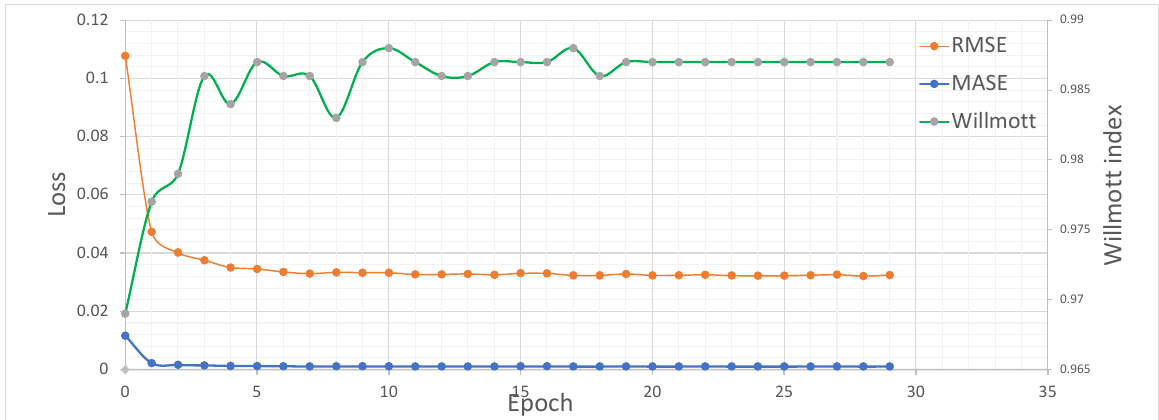
however Willmott’s index was around 0.987 with space of improving. The optimum values were in Epoch 10 with minimal MASE, RMSE, and Willmott’s with values of 0.0012, 0.0034, and 0.988 respectively. The MASE and RMSE minimum remain stable throughout the epochs, and Willmott’s index stabilizes at 0.987.